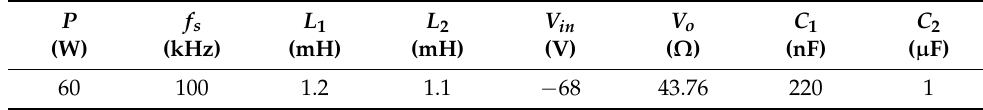
Table 6. Parameter values design Cuk